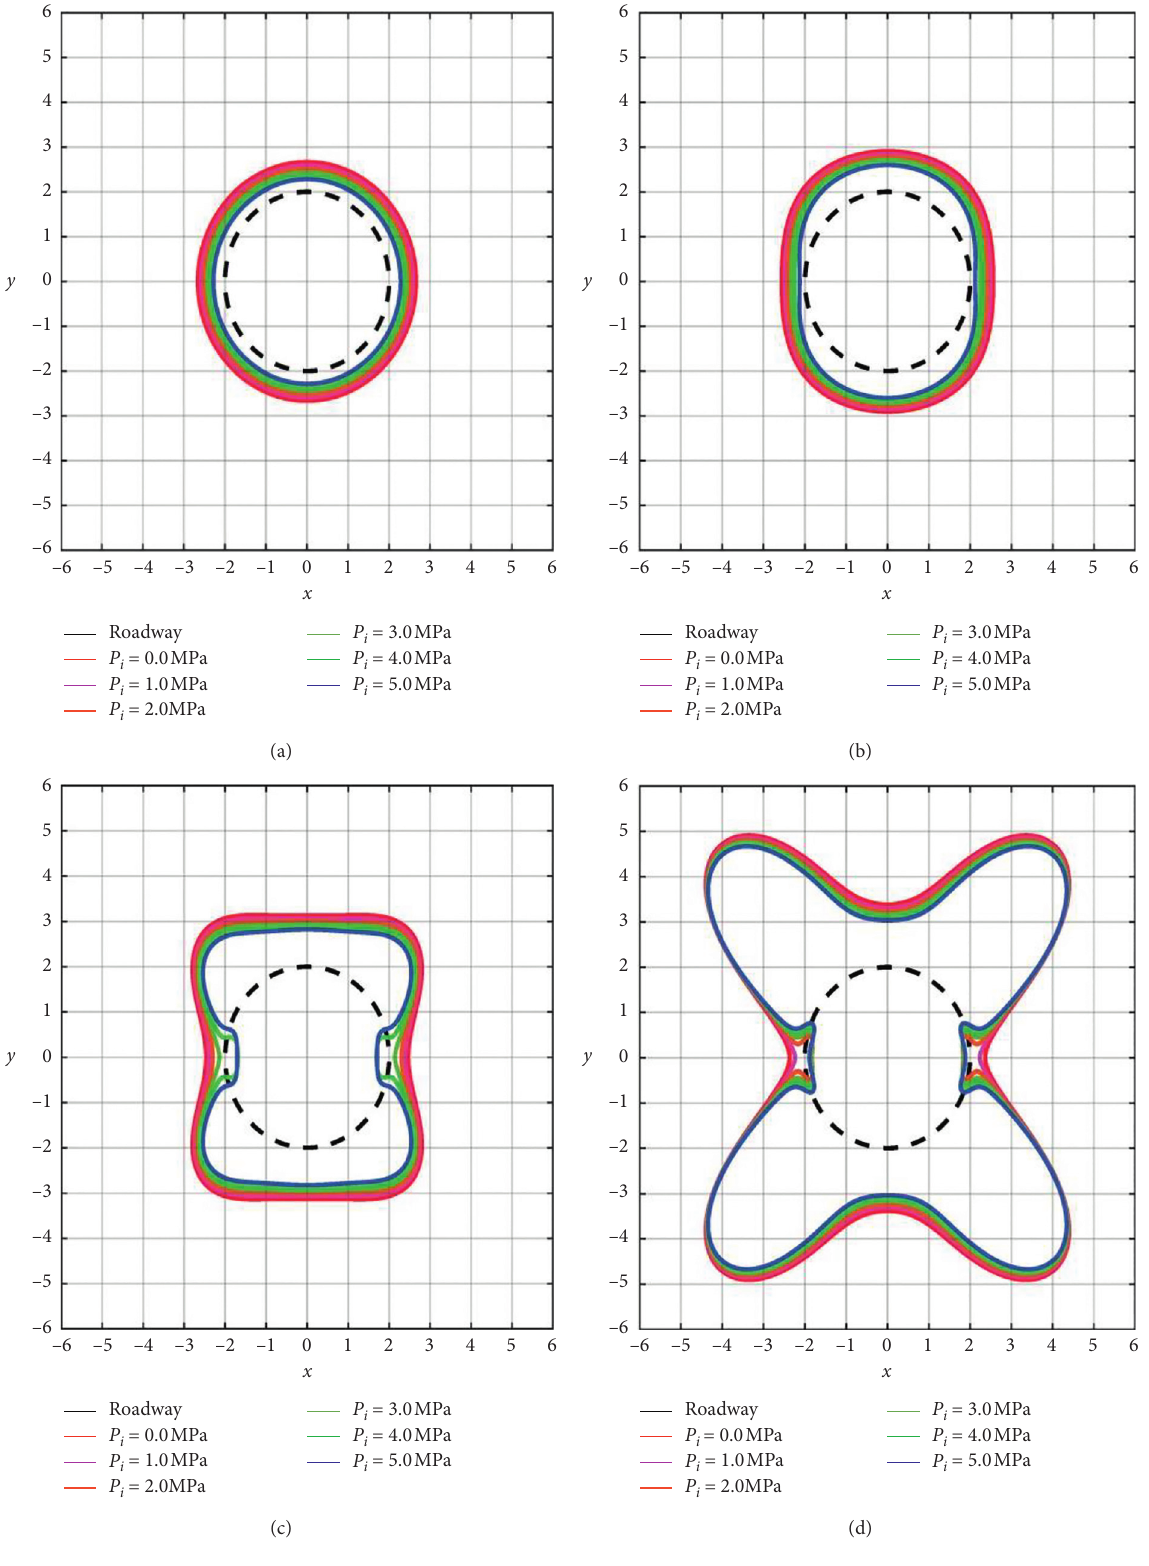
Figure 12: Relationship between tunnel radius and shape of plastic zone. (a) λ � 1.00. (b) λ � 1.48. (c) λ � 1.96. (d) λ �